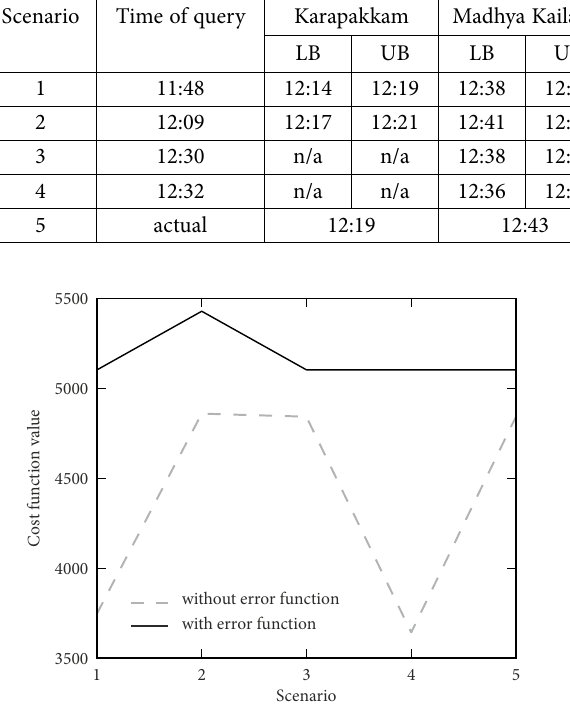
Figure 12. Cost function value against scenario with and without the error